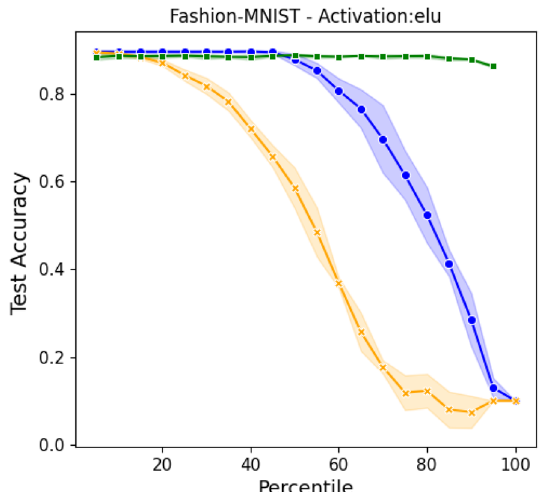
Figure 4. Accuracy on the Fashion-MNIST database with respect to the percentage of pruned nodes (from the hidden layers), in a five layers feedforward architecture. Here, N 2 = N 3 = N 4 = 500 , while N 1 = 784 and N 5 = 10 , as reflecting the structural characteristics of the data. Symbols and colors are chosen as in Fig.